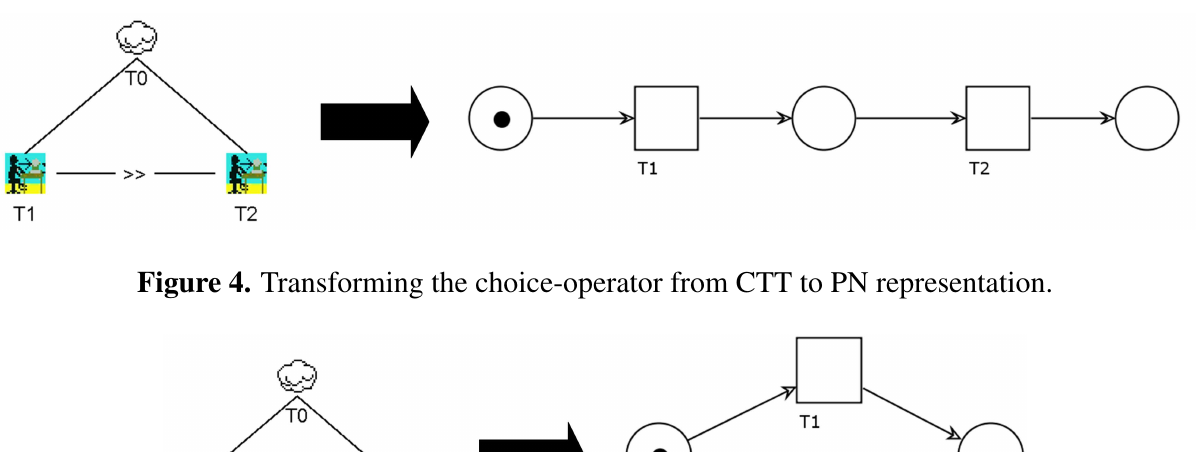
Figure 3. Transforming the sequential enabling-operator from CTT to PN representation.